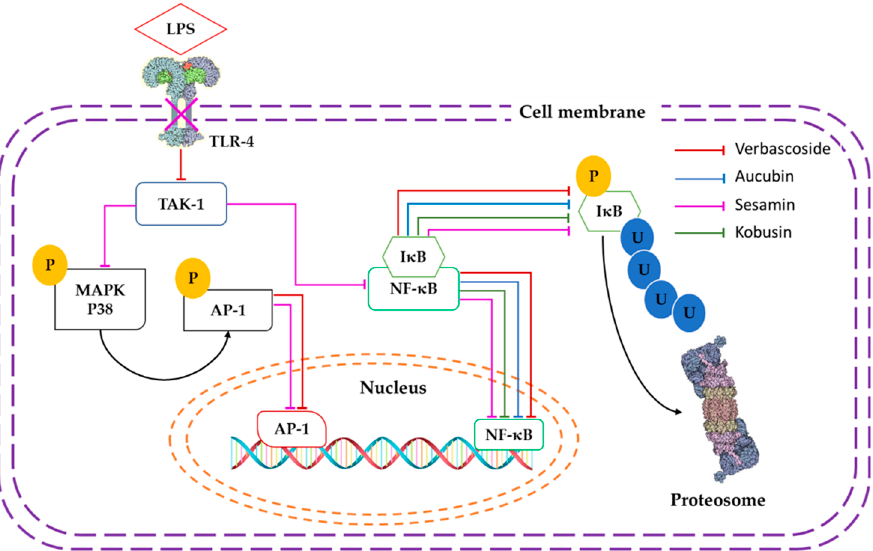
Figure 2. Proposed inhibition mechanism of the verbascoside-kobusin and verbascoside-aucubin mixtures in RAW-Blue ™ cells. Continuous line indicates enzyme inhibition. Crossed line indicates inhibition of expression. TLR-4: toll-like receptor 4. AP-1: activator protein. I κ B: inhibitor of κ B. TAK-1: transforming growth factor- β -activated kinase 1, MAPK p38: mitogen activated protein kinase p38. NF- κ B: nuclear factor κ B. U: ubiquitin, P: phosphate.